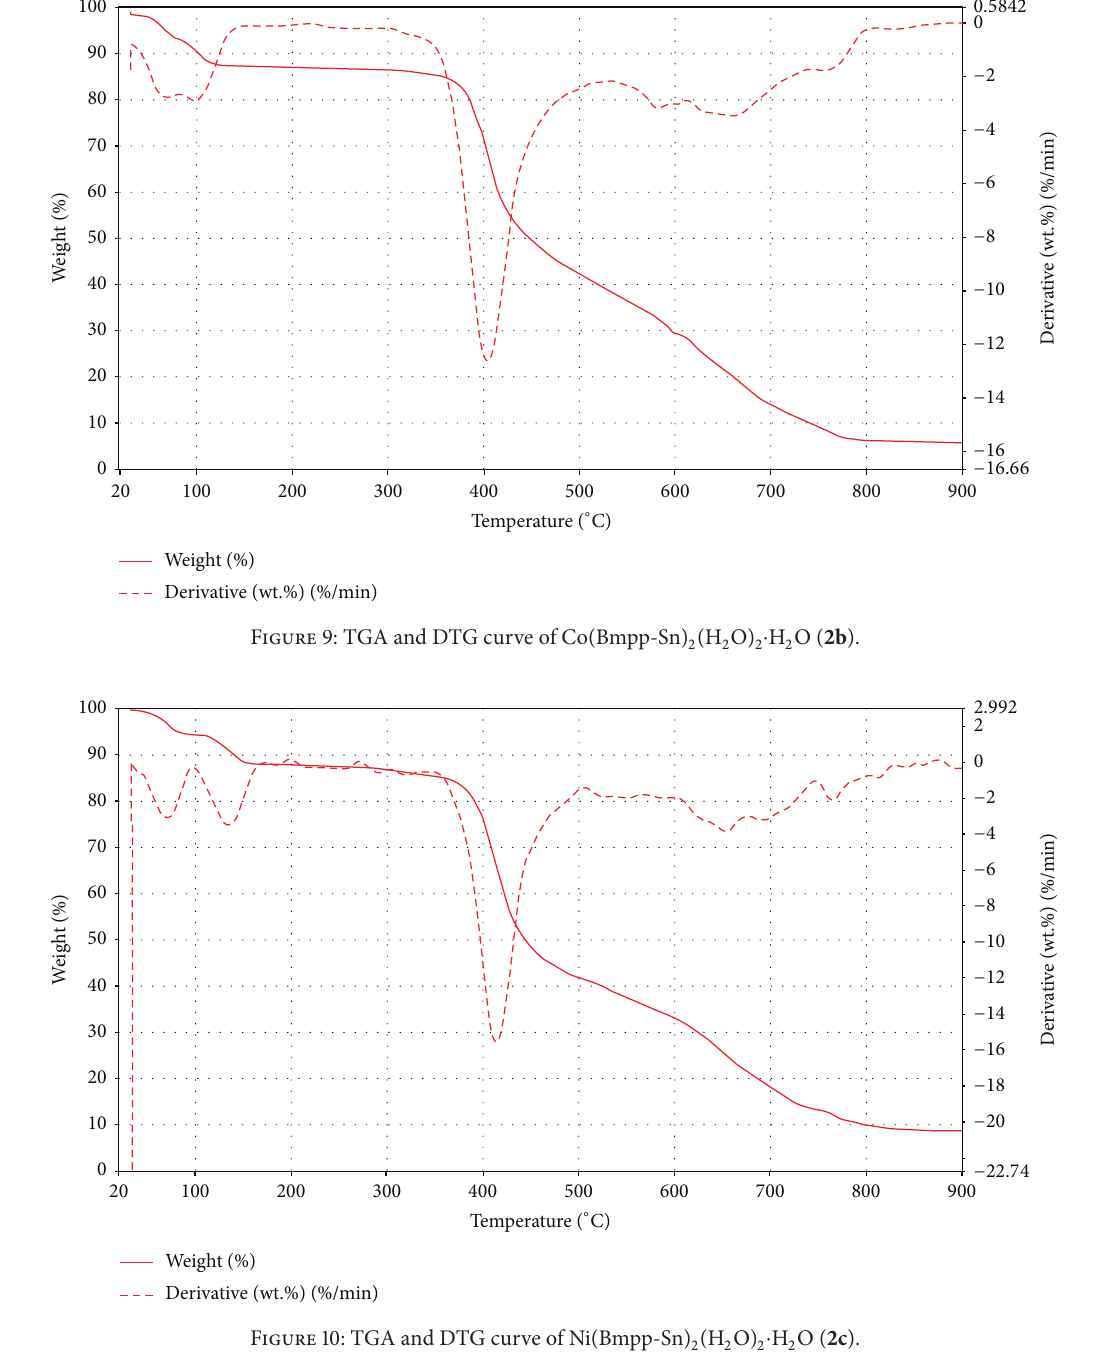
Figure 10: TGA and DTG curve of Ni(Bmpp-Sn) 2 (H 2 O) 2 ⋅ H 2 O ( 2c